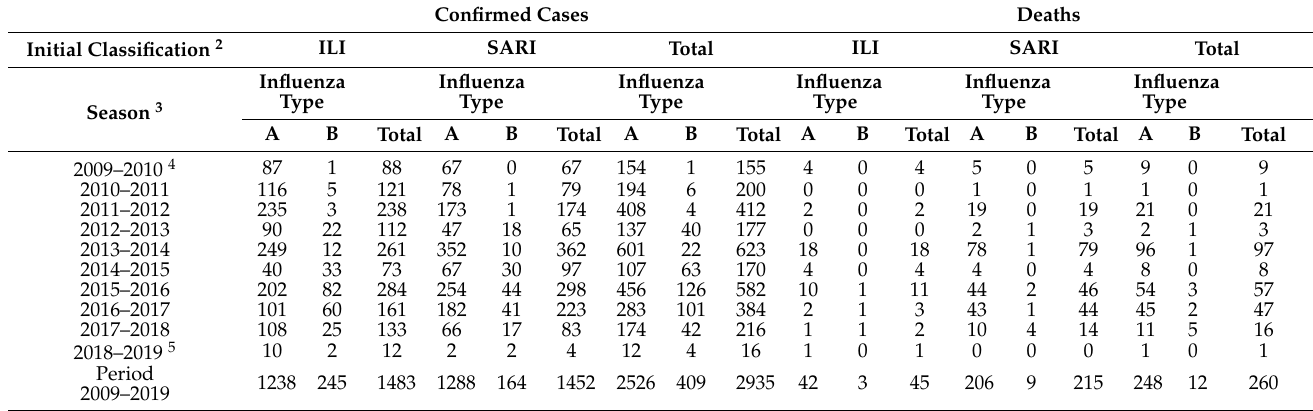
Table 2. Confirmed cases and deaths in the target population 1 .